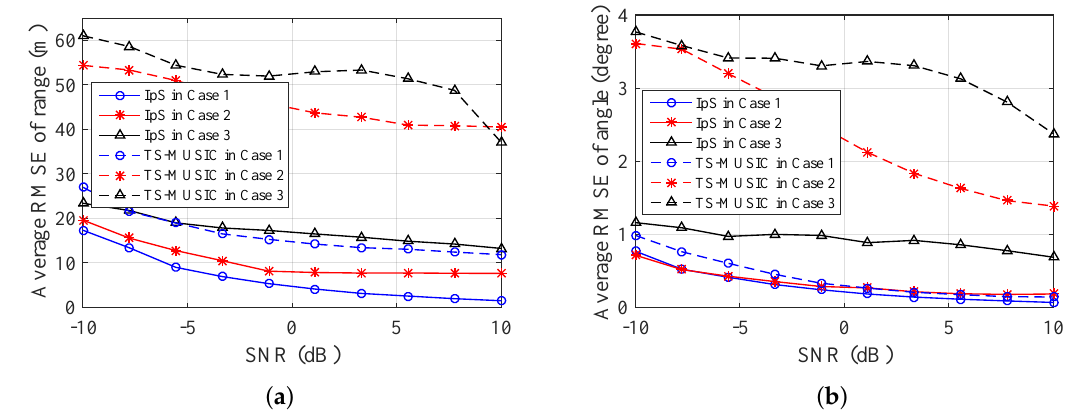
Figure 8. RMSE of unresolved targets localization in ( a ) range and ( b )